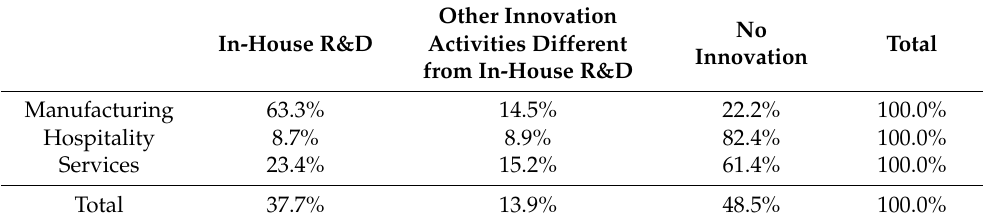
Table 6. Innovative firms by industry. Other Innovation In-House R&D Activities